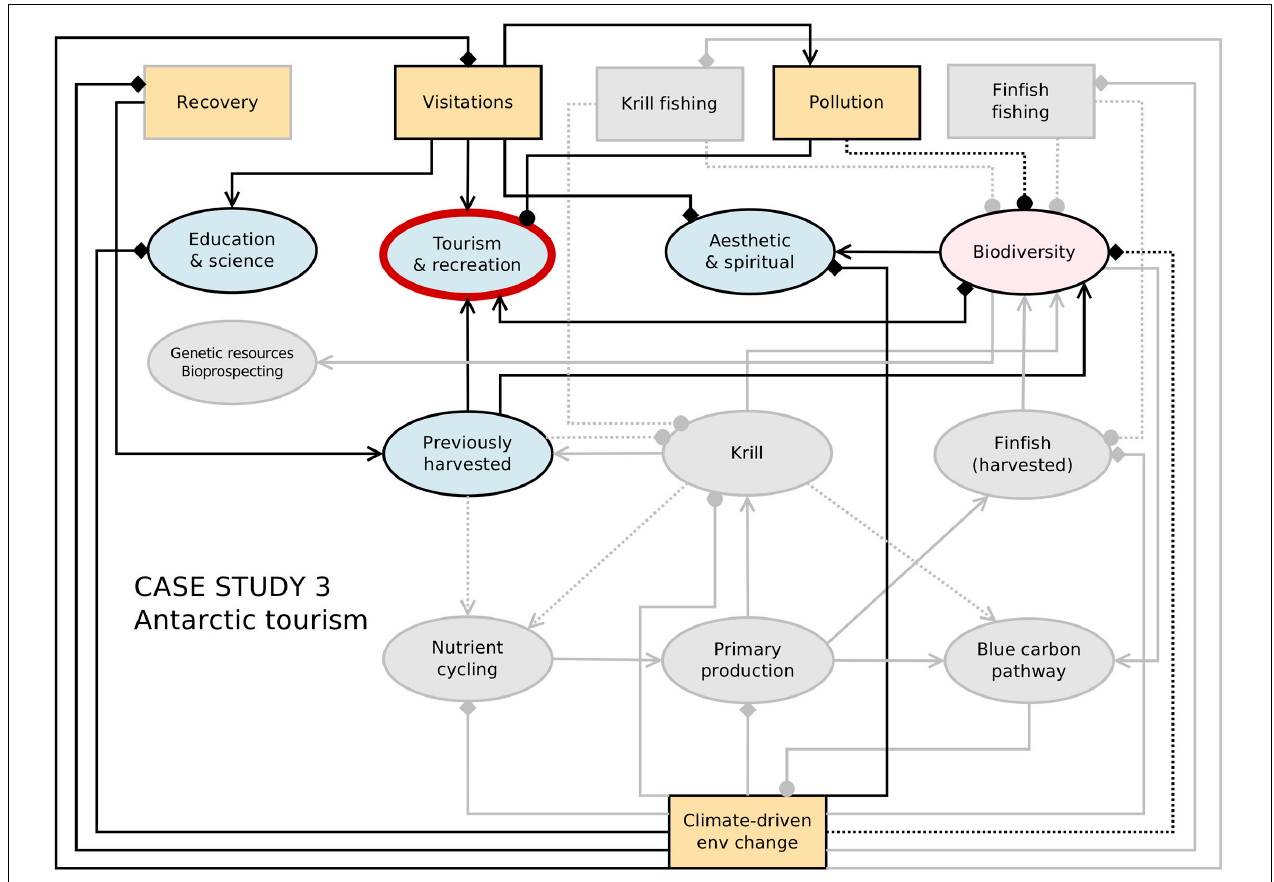
FIGURE 5 | Network representation of the links and feedbacks between ecosystem services and drivers (from Figure 2 ) with key elements for Antarctic tourism highlighted. Connections between components indicate the direction of effects from one node to another, as indicated in the legend. Diamonds indicate cases where the direction of the effect is not known or unclear (i.e., it could be positive and/or negative), and dashed lines represent uncertain or weak linkages.